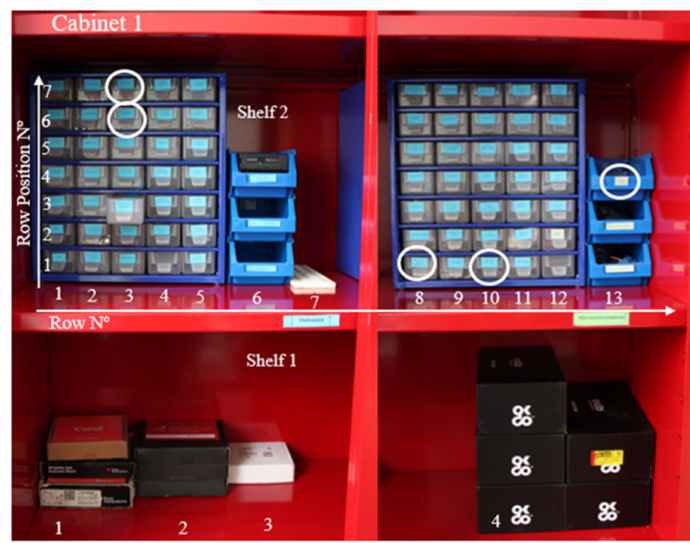
Figure 2. Numbering assigned according to